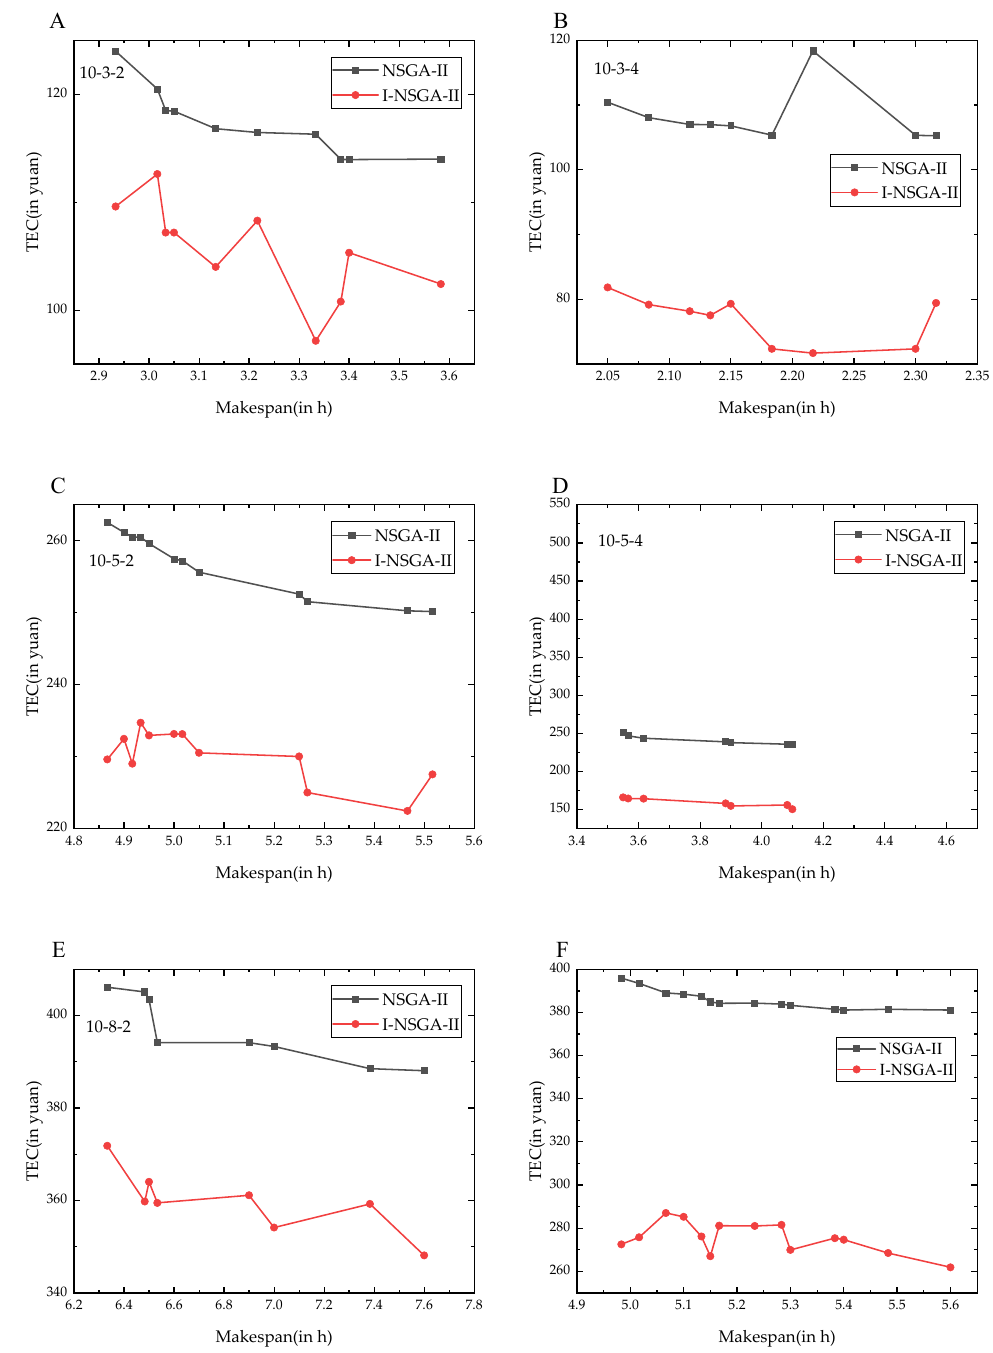
Figure 9. Pareto fronts found by each algorithm for 10-job instances.